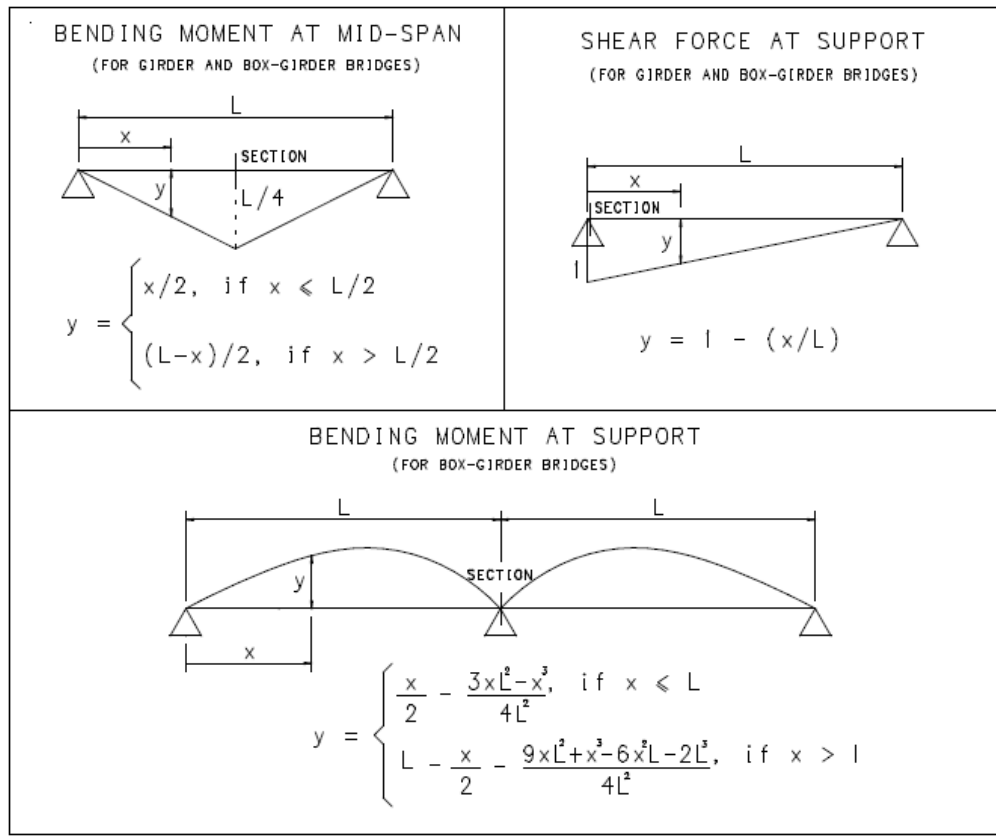
Figure 10. Influence